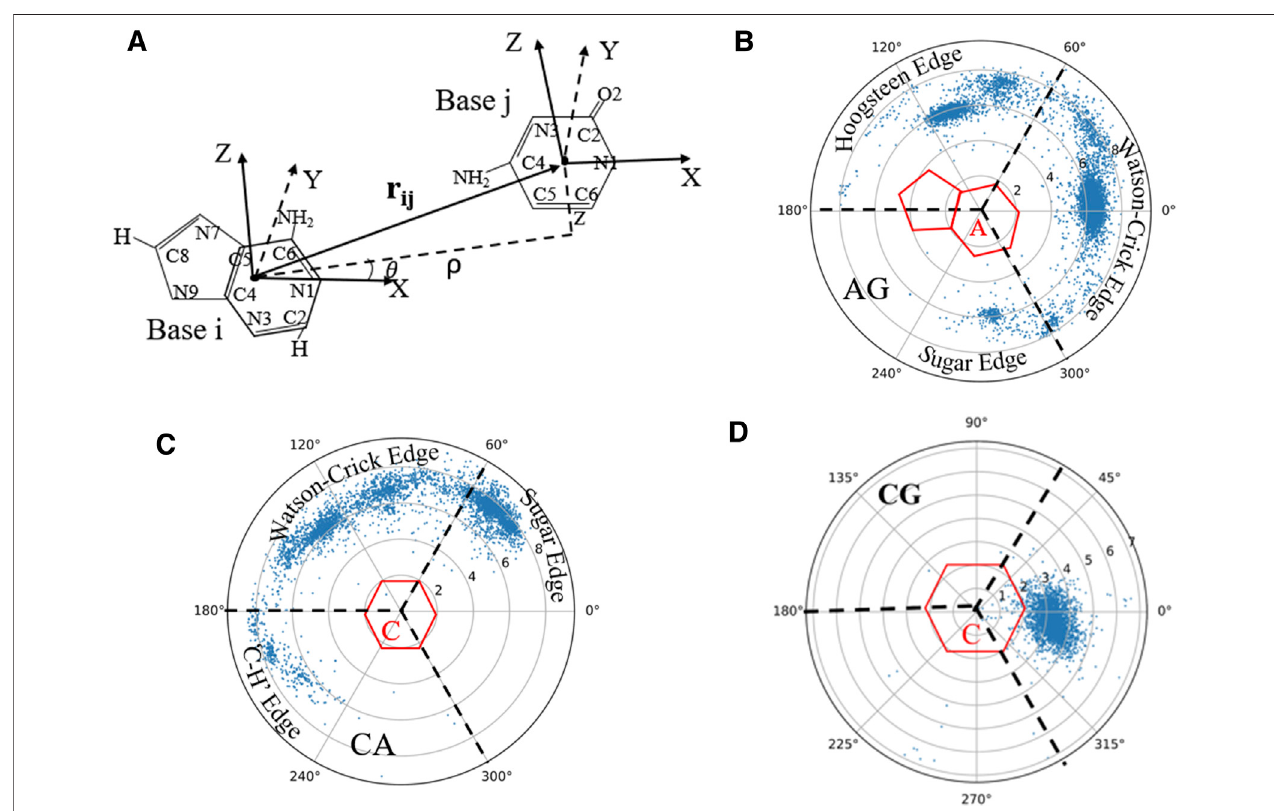
FIGURE4|(A) Thede fi nitionofthelocalcoordinatesystemforbases,andinthecoordinatesystemofonebase(e.g., i ),thepositionofanotherbase(e.g., j )canbe described by the vectors r ij , expressed in cylindrical coordinates. (B) Distribution of ( ρ , θ ) for base U near its paired base A. (C) Distribution of ( ρ , θ ) for base A near its paired base C. (D) Distribution of ( ρ , θ ) for the base G near its stacked base C. In (B – D) , the three interacting edges of each base (Watson – Crick, Hoogsteen/C-H, and sugar) correspond to positions in the three sectors of the map demarcated by the dotted lines, and the dots are from the statistics on the RNA structures in our dataset (see in Materials and